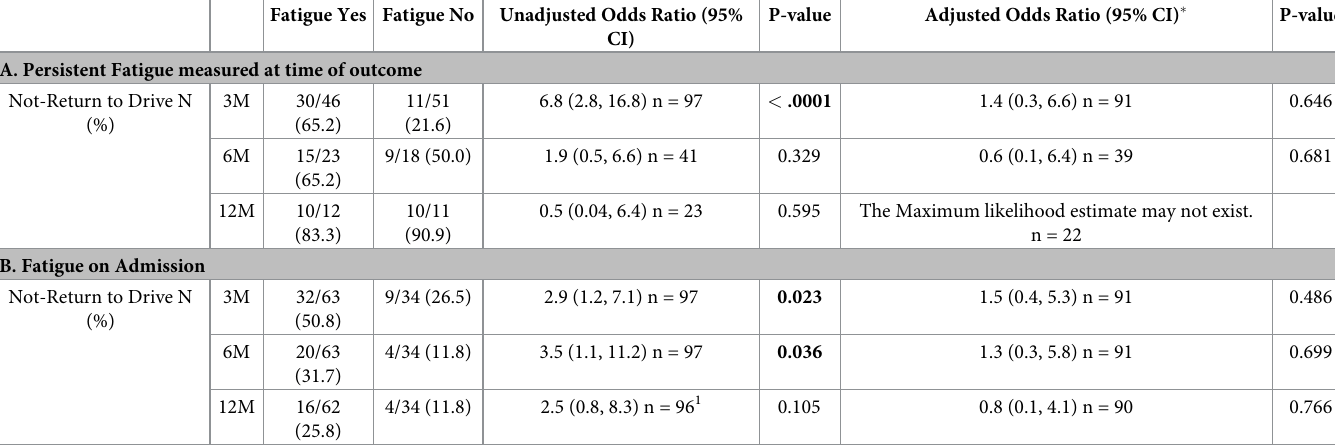
Table 3. Association between fatigue and not returning to